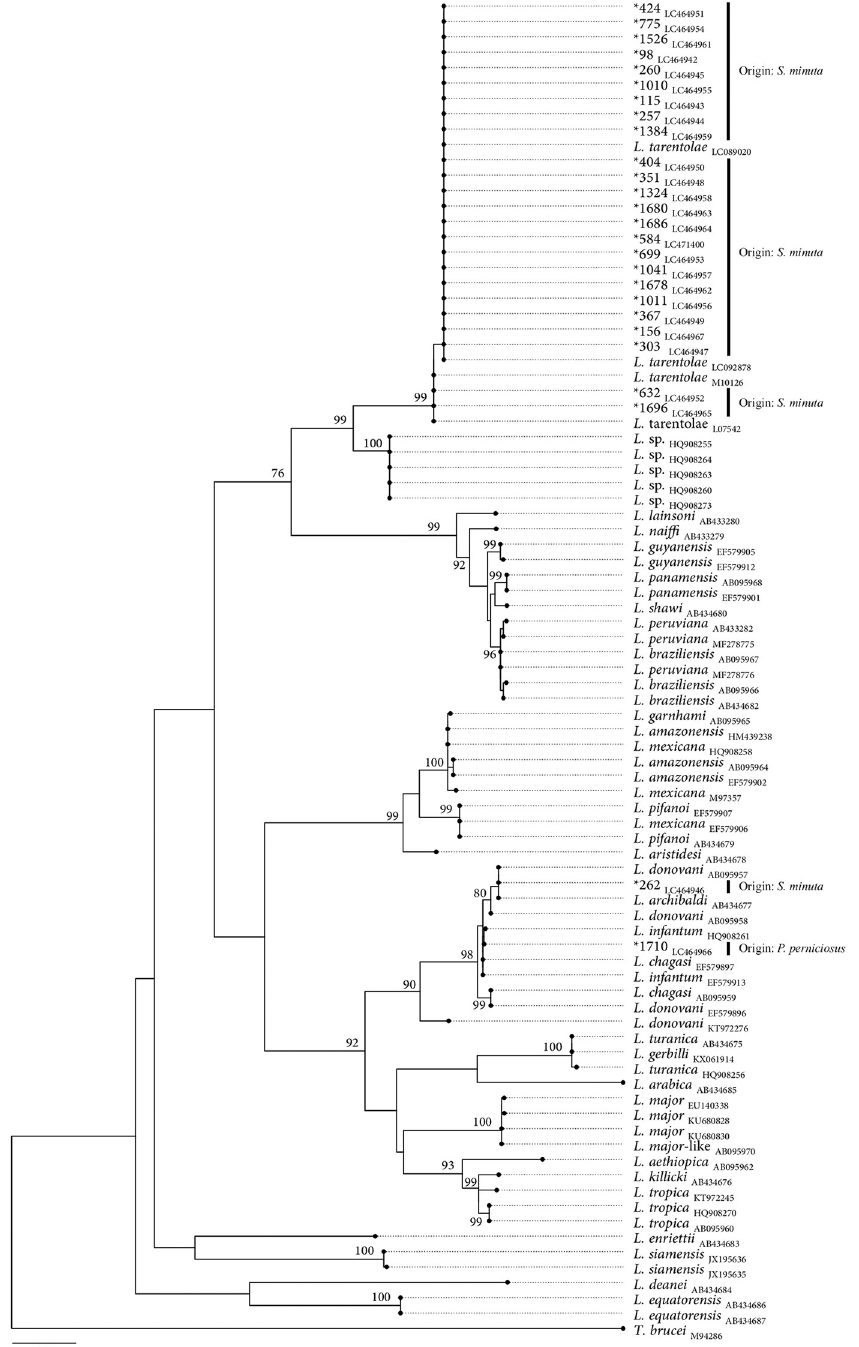
Fig 2. Maximum likelihood phylogenetic tree based on unambiguous multiple- Leishmania cytB sequences alignment, using the GTR+G+I model of evolution.